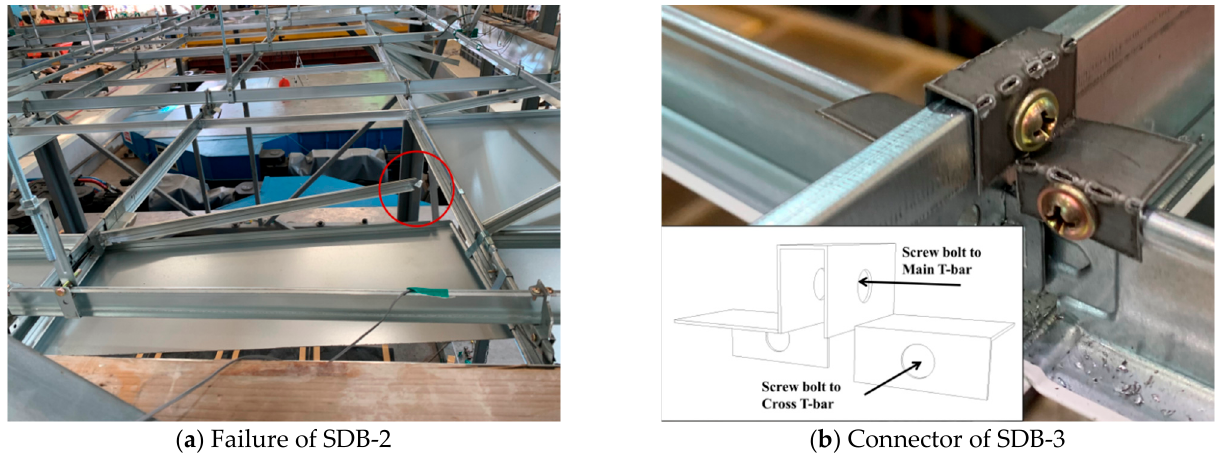
Figure 19. Main T-bar–cross T-bar connection used in the specimens. ( a ) Connection failure of the main T-bar–cross T-bar joint, SDB-2, and the ( b ) main T-bar–cross T-bar connector, SDB-3.